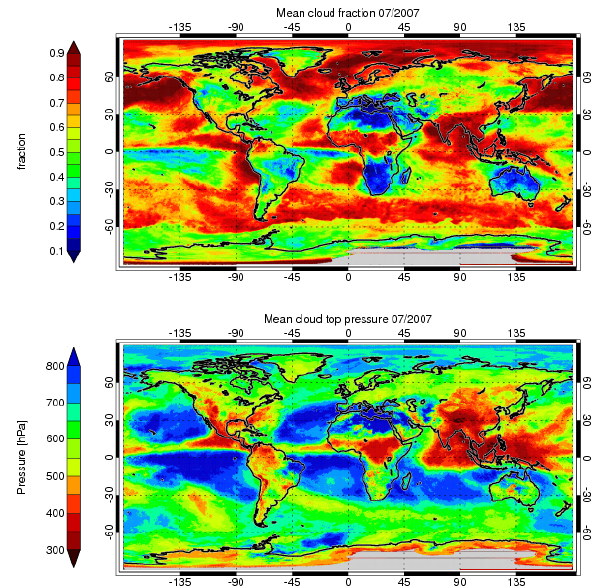
Figure 2. Global monthly mean cloud fractional coverage (top) and cloud top pressure 4 Fig. 2. Global monthly mean cloud fractional coverage (CFC) (top) and cloud-top pressure (CTP) [hPa](bottom) for July 2007 derived [hPa](bottom) for July 2007 derived from four satellites (see Figure 1). Regions without 5 from four satellites (see Fig. 1). Regions without values are grey- values are grey-shaded (here resulting from problems due to insufficient radiometric 6 shaded (here resulting from problems due to insufficient radiomet- resolution for very cold surfaces in Antarctica during the Polar winter). 7 ric resolution for very cold surfaces in Antarctica during the polar winter).